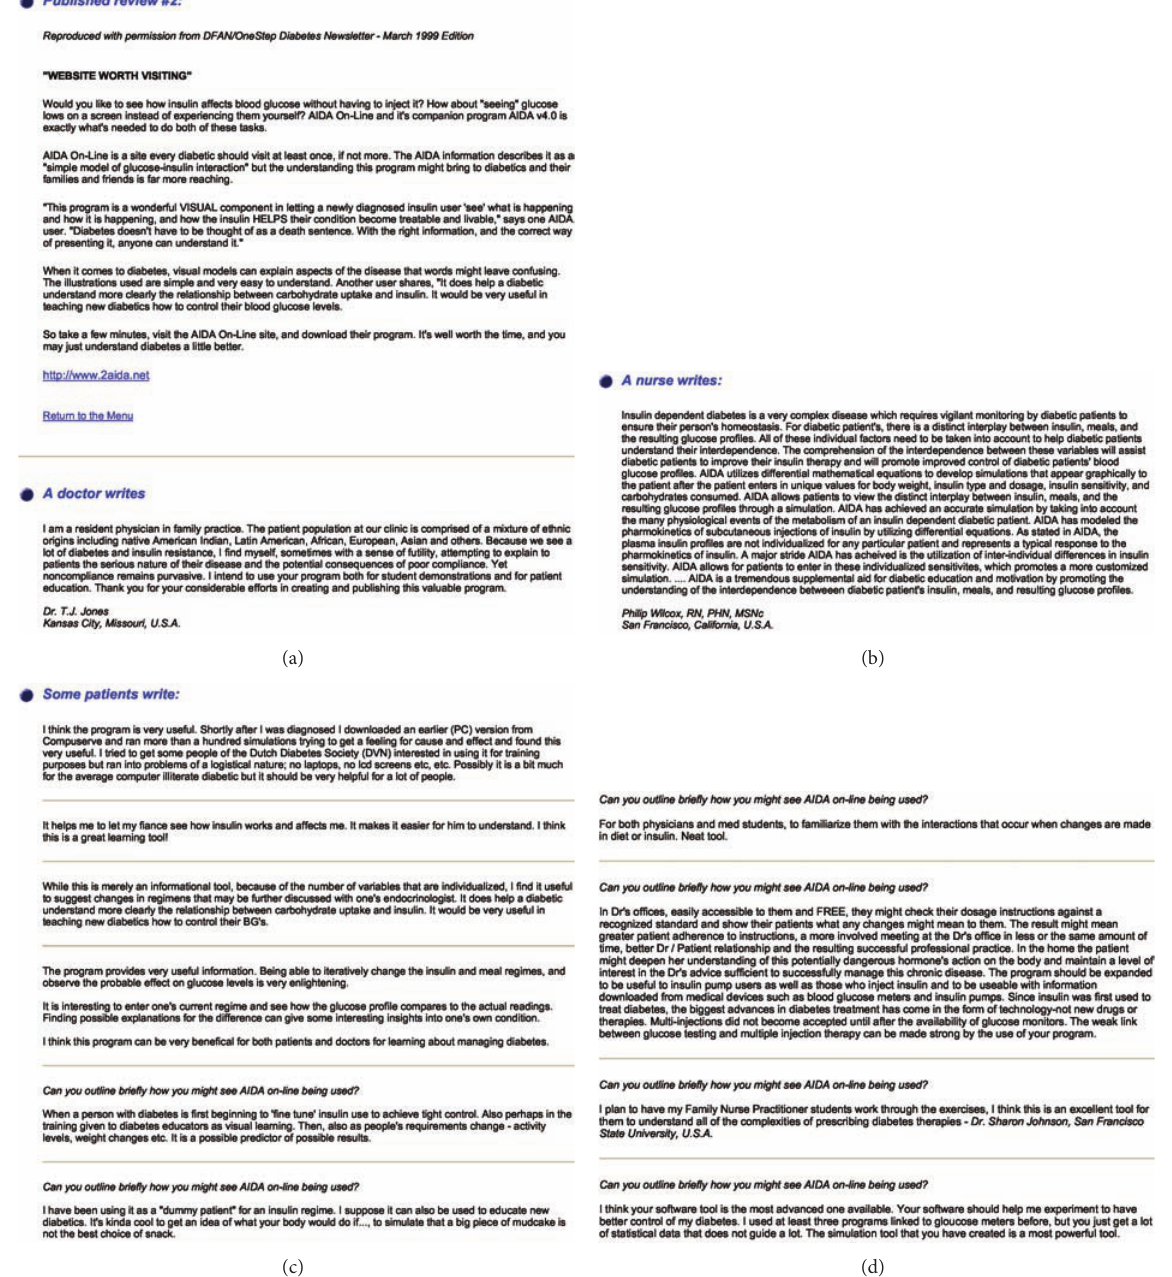
Figure 7: Independent user reviews of AIDA online, reproduced from the AIDA online website (http://www.2aida.org/aida/online-